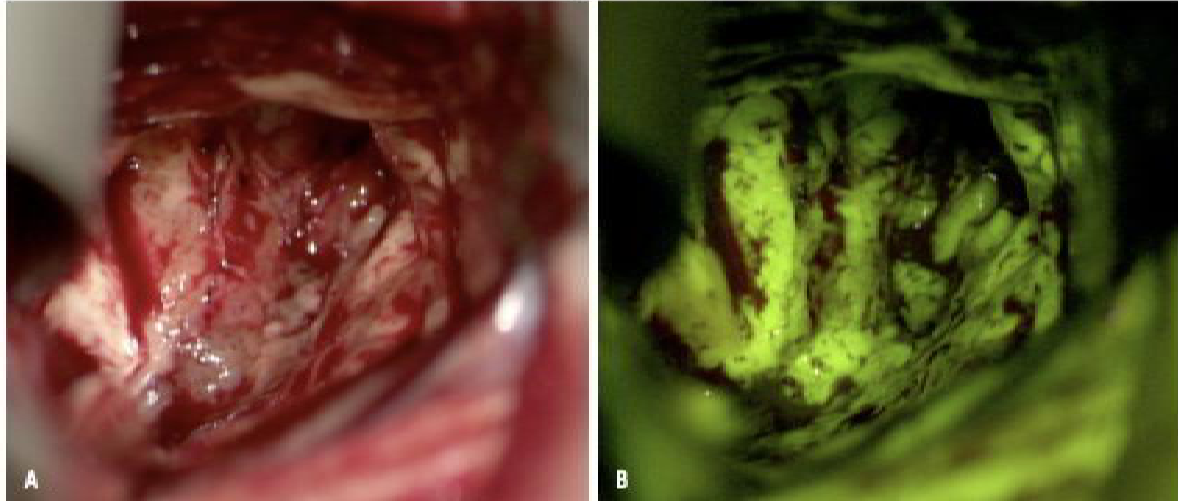
Figure 3. Fluorescence-guided surgery using fluorescein sodium for resection of a high-grade glioma. ( A ) shows the resection cavity under white light and ( B ) shows the green-yellow fluorescence under fluorescence. Fluorescein is not tumor-specific, as seen by the extravasated fluorophore within normal brain tissue and edematous brain. (Permission from Hadjianapyis CG et al. Fluorescence Guided Brain Tumor Surgery. Youmans & Winn Neurological Surgery 8th Edition. Chapter 157B. New York: Elsevier; 2021) [21].